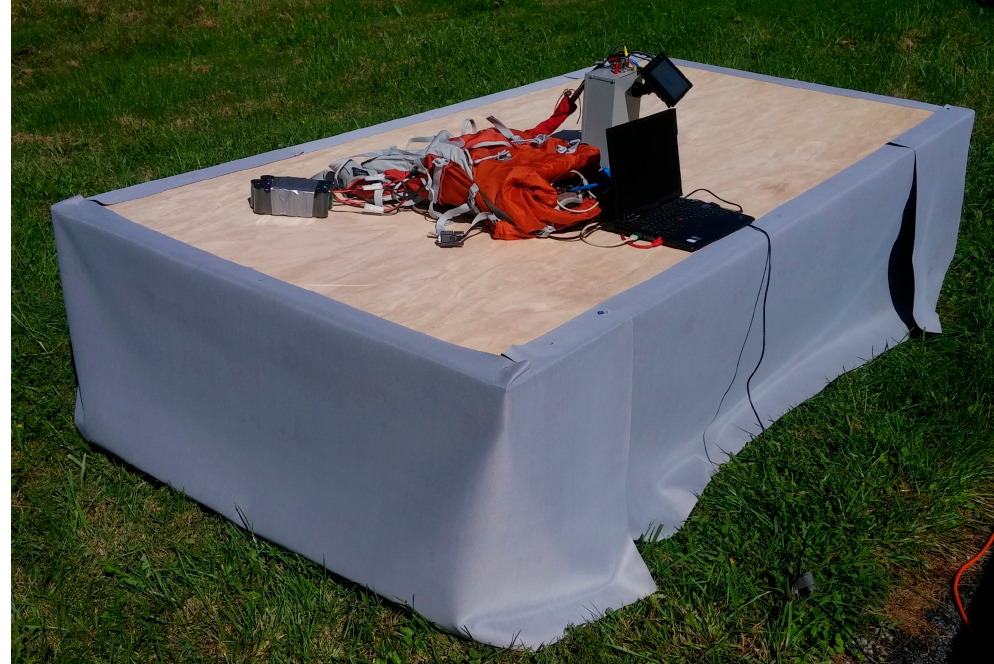
Figure 1. Shroud with camera. Orange backpack is tethered to the camera and is used to house electronics when the camera system is used in a portable mode.